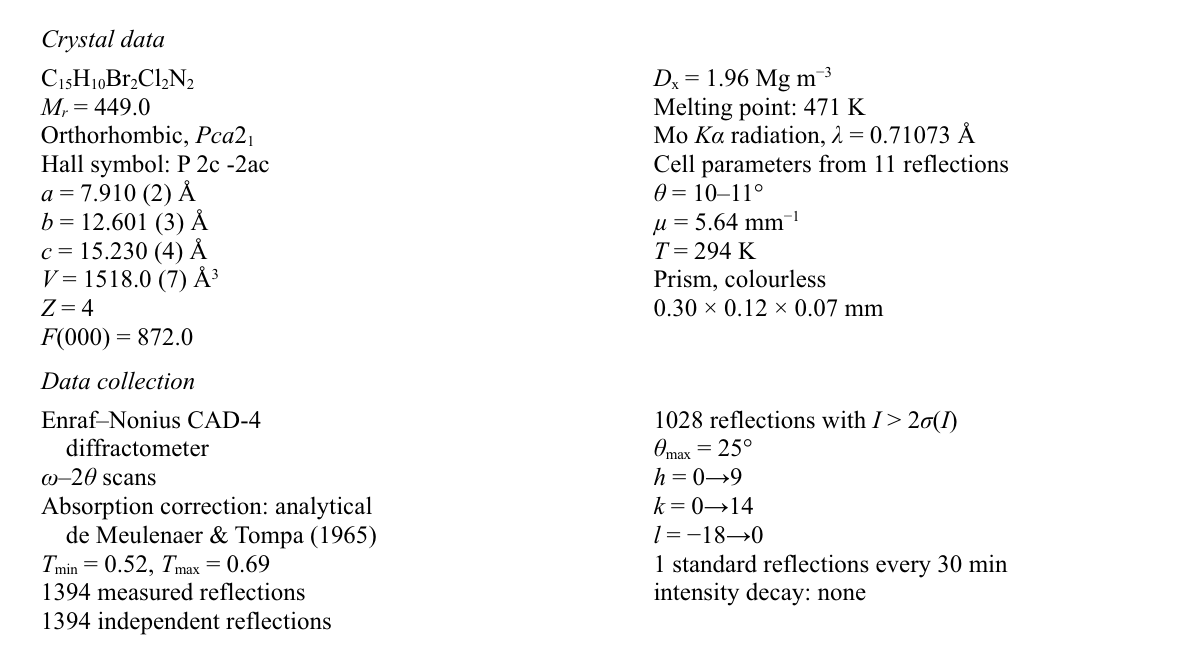
Figure 2 Synthetic scheme for the synthesis of (I) showing the numbering system used in naming the compound. 2,8-Dibromo-4,10-dichloro-6 H ,12 H -5,11- methanodibenzo[ b , f